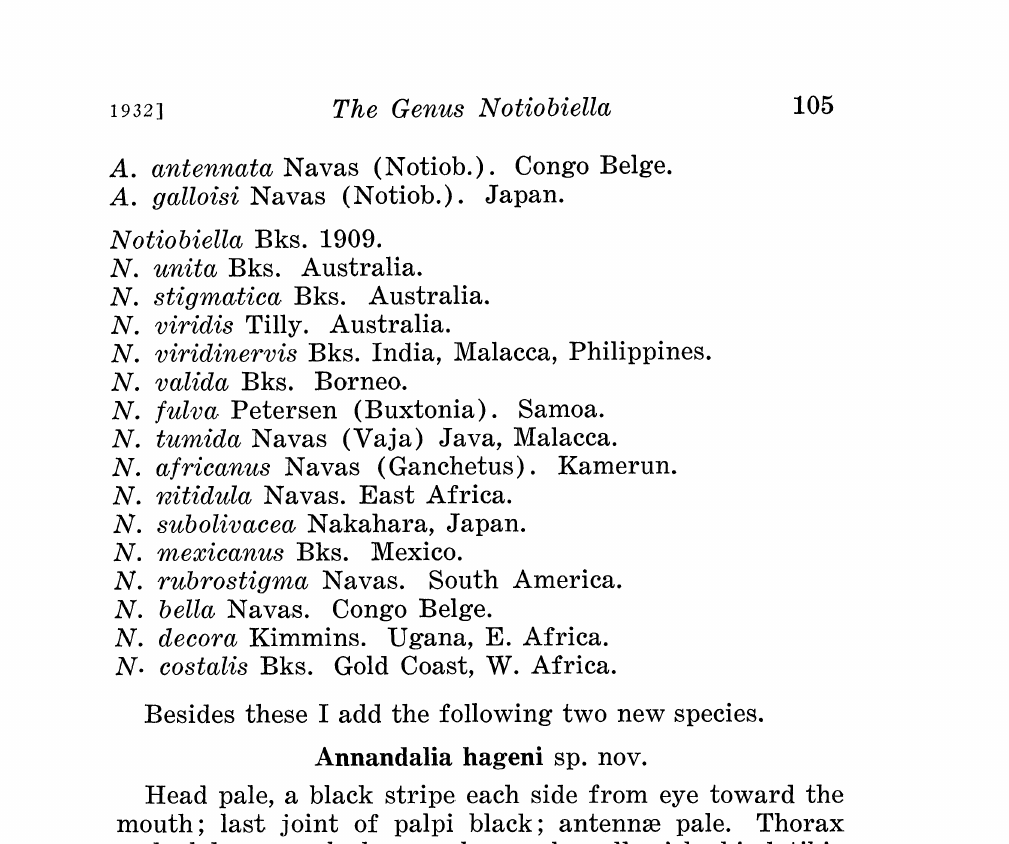
with a short dark stripe each side near middle. Wings pale, veins brown, a black dot near base o.f median vein, and the gradate series dark, stigma not marked. Wings longer tha.n in A. iniquus, more than twice as long as broad, the subcosta and radius wide apart as in that species, and a cross-vein one-third way out; first radial sector at its first ork is connected to radius by a cross-vein and the second radial sector is twice forked before the marginal ork; most of the costal veinlets are orked but once, and one or two simple. There is a cross-vein between radius, and second radial sector in the iore-wing beyond the. stigma (not in other species) and also a cross-vein between the upper branch o the first radial sector and the lower branch oi the second radial sector out near the tip close to the marginal